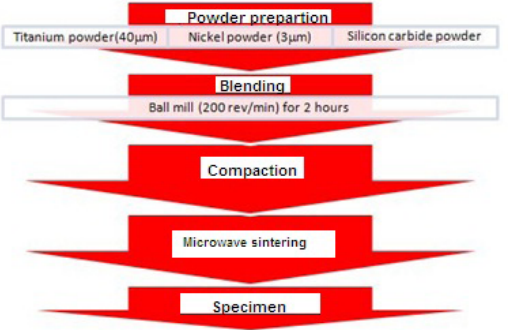
Figure 1. Stages of sintering process.